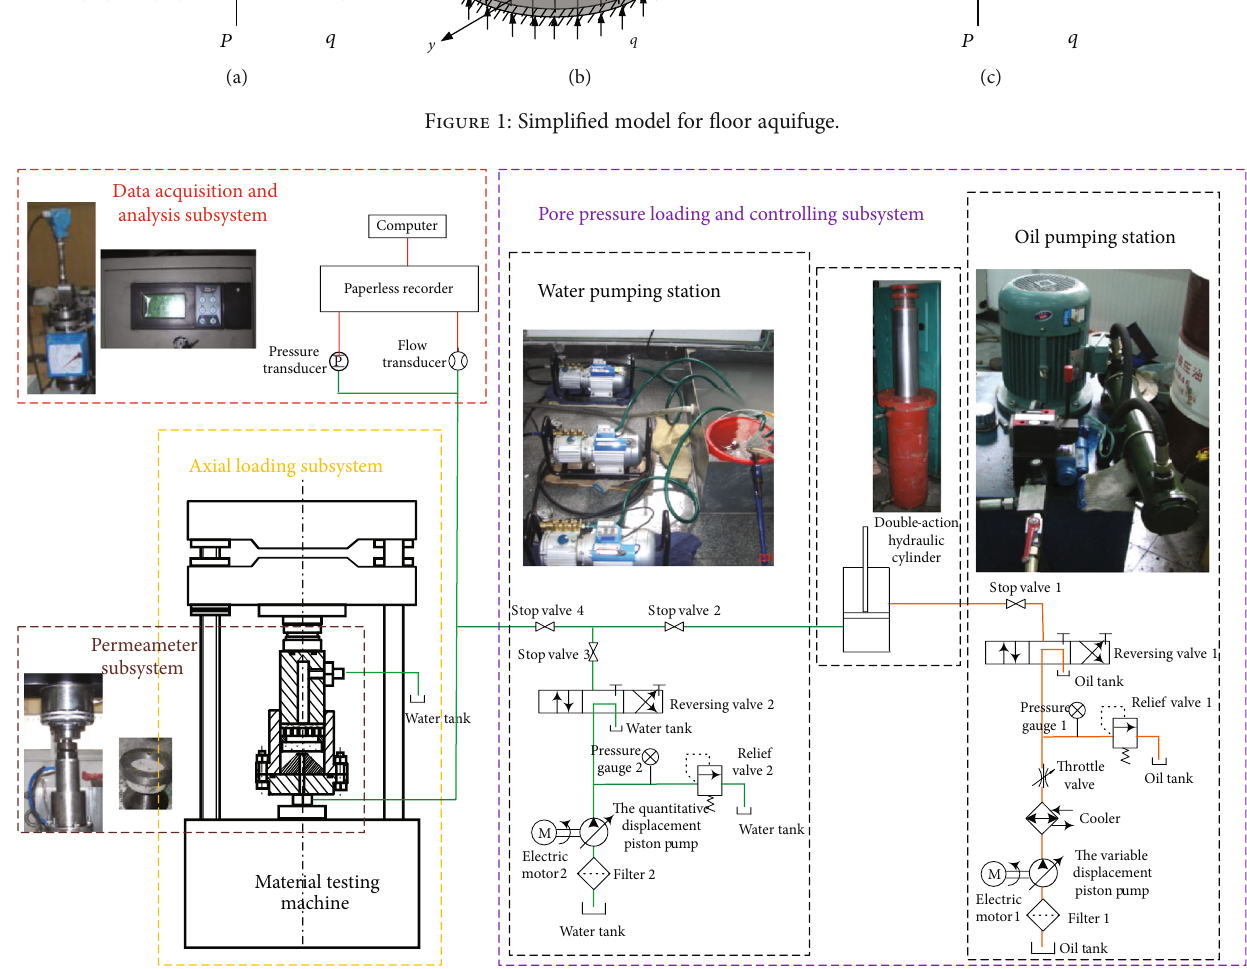
Figure 2: Testing